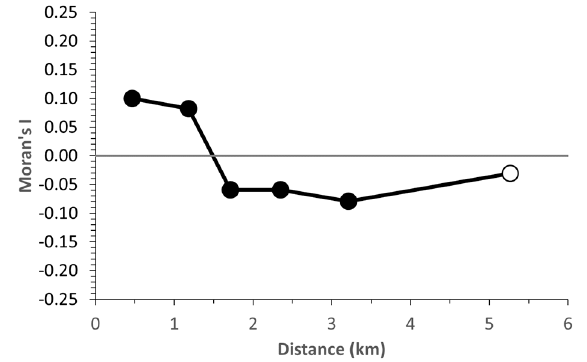
Figure 3. The influence of geographic distances in kilometers using the computed Moran’s I from the observed incidence of the carpenter ant in the Czech Republic. Full circles represent p < 0.05, empty denote non-significant values.